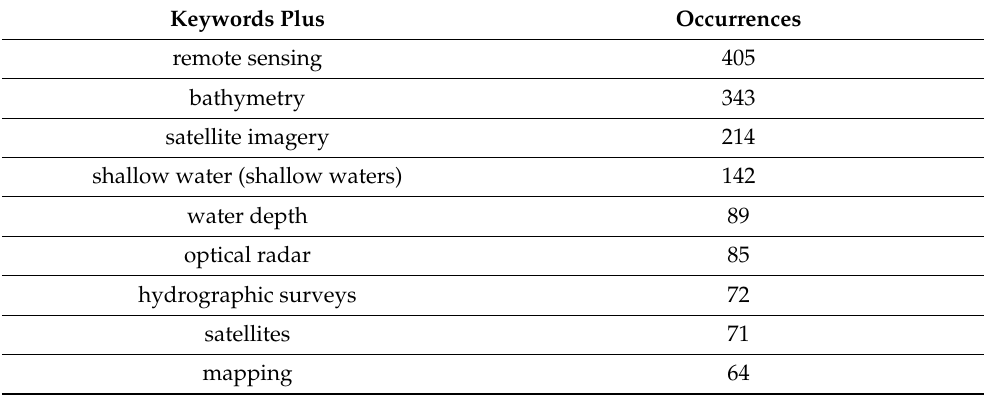
Table 7. Fifteen most-occurring Keywords Plus for SDB (WoSCC and Scopus